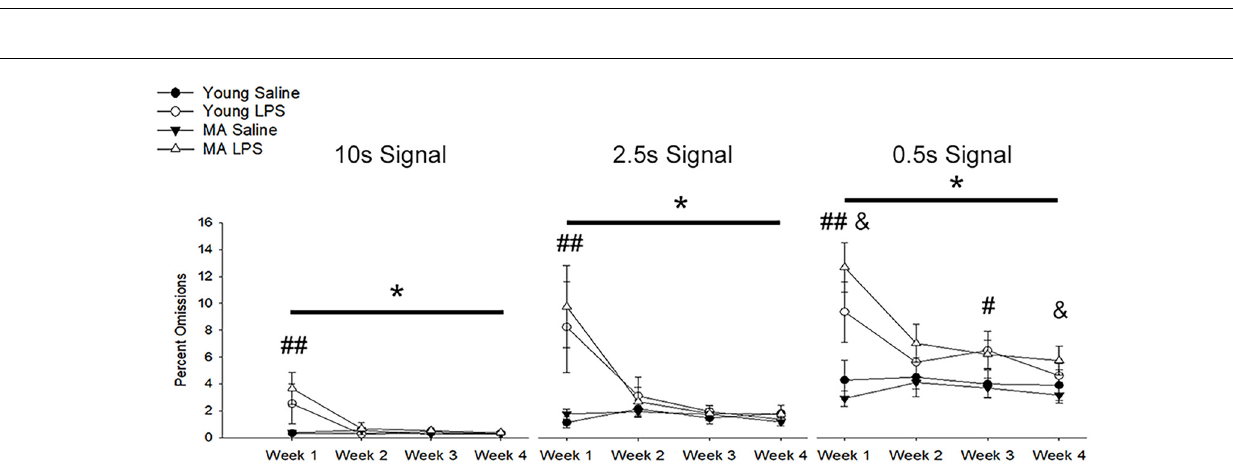
FIGURE 4 | Inflammation increased omission rates, with greater effects for middle-age rats on the shortest signal trial. During the first week of LPS treatment, omission rates significantly increased for all signal trial types (all p < 0.01), likely due to sickness behavior inducing a reduction in motivation. In addition, LPS-treated rats displayed greater omissions, which remained high for multiple weeks, on the shortest signal duration of 0.5 s compared to controls (week 1: p < 0.001; week 2: p = 0.09; week 3: p = 0.02; week 4: p = 0.08), which may indicate the persistent impairing effect of inflammation on attentional function after sickness behavior resolves. Given their hypothesized enhanced susceptibility to inflammation, middle-age rats were separated from young to evaluate whether they were driving this effect. As expected, while young rats tended to display a sickness-related increase in omissions during week 1 ( p = 0.08), middle-age rats had higher omission rates for most weeks (week 1: p < 0.001; week 2: p = 0.07; week 3: p = 0.07; week 4: p = 0.05). Data are presented as means ± SEM. ∗ p < 0.05, # p < 0.05, ## p < 0.01, interaction of treatment and week; & p ≤ 0.05, interaction of age, treatment, and